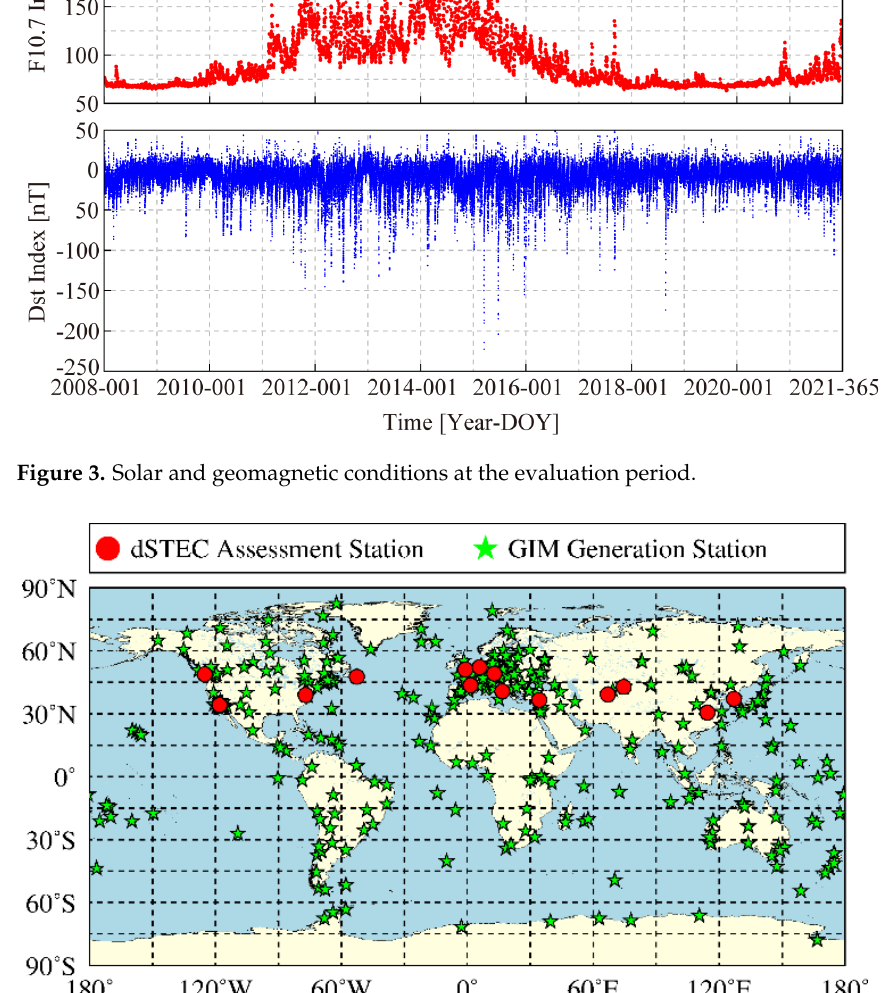
Figure 3. Solar and geomagnetic conditions at the evaluation period.